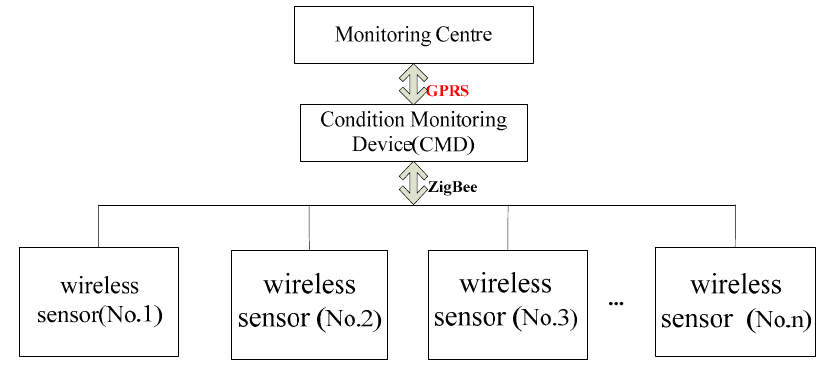
Figure 2. Thefunctionalblocksofanonlinemonitoringsystemforconductorgallopingoftransmissionlines. Figure 2. The functional blocks of an online monitoring system for conductor galloping of transmission lines. Figure 2. The functional blocks of an online monitoring system for conductor galloping of transmission lines. Figure 2. The functional blocks of an online monitoring system for conductor galloping of transmission lines.